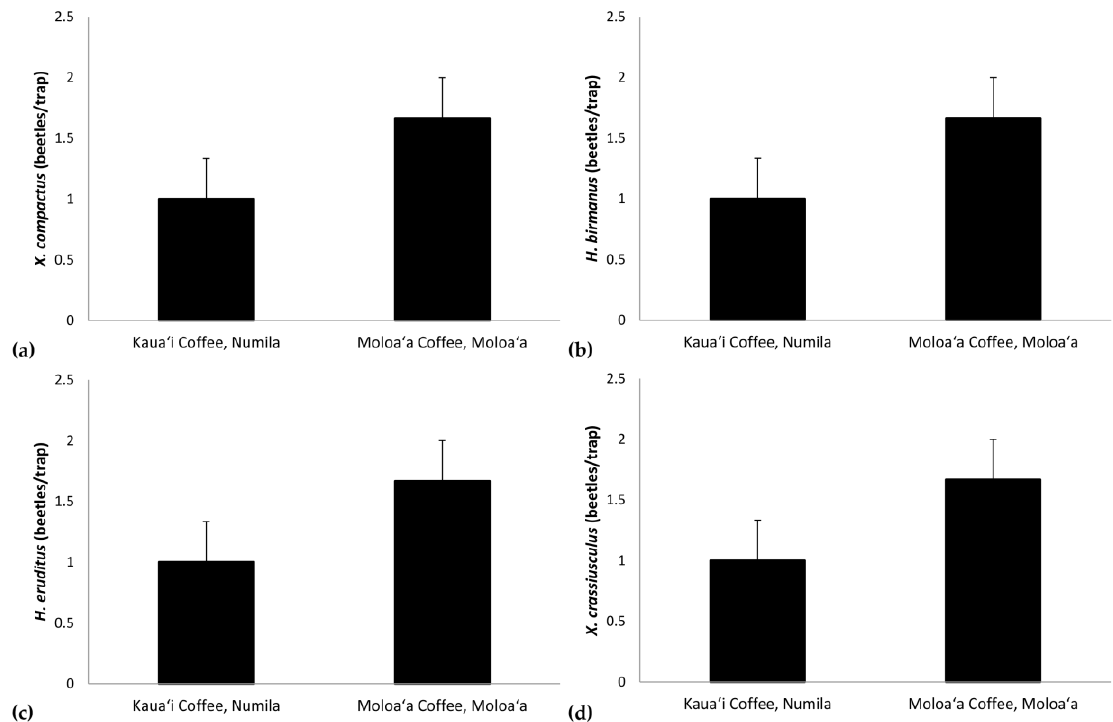
Figure 7. Mean density per trap ( ± standard error) for ( a ) Xylosandrus compactus , ( b ) Hypothenemus birmanus , ( c ) H. eruditus , and ( d ) X. crassiusculus at the Kaua ʻ i Coffee Company (tropical dry savanna) versus Moloa ʻ a Bay Coffee (tropical wet forest).